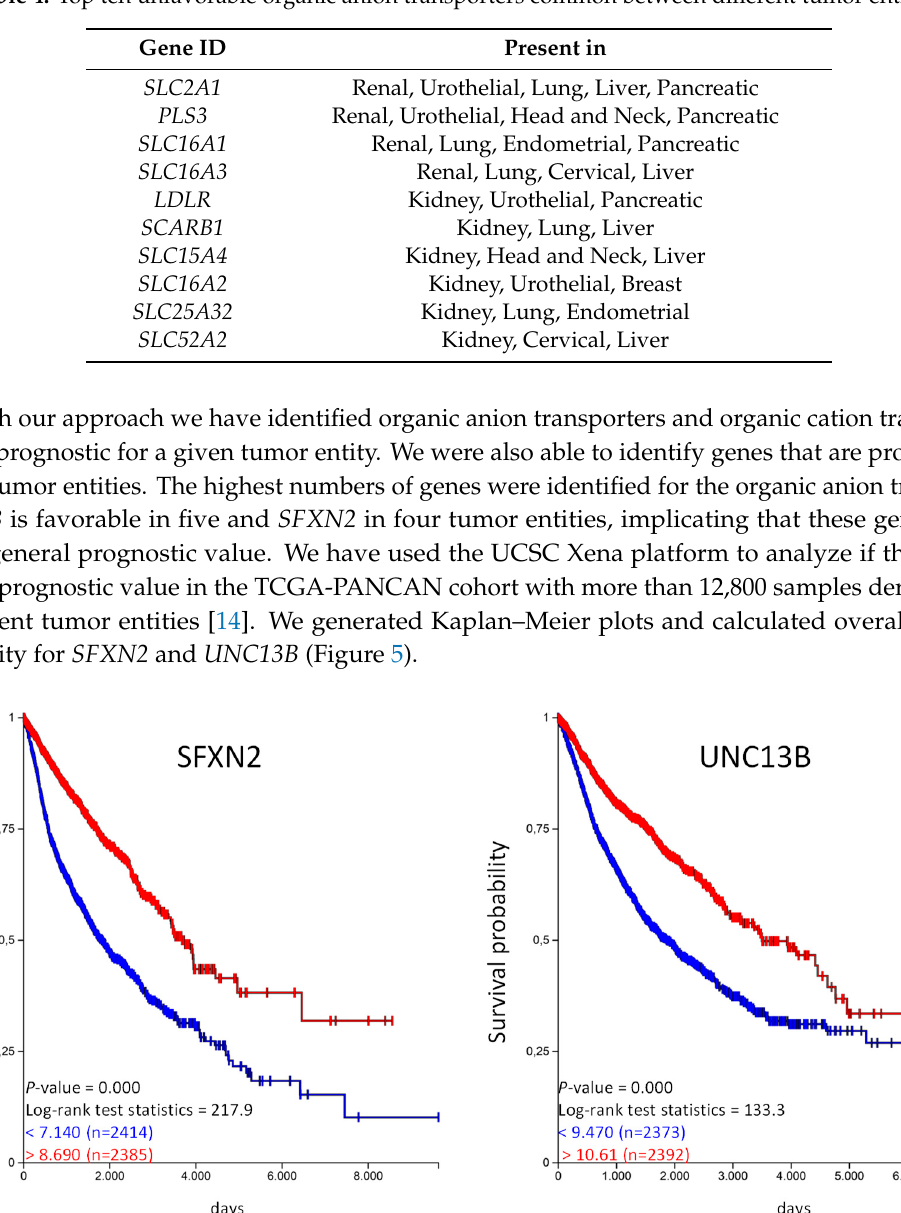
Table 4. Top ten unfavorable organic anion transporters common between different tumor entities.